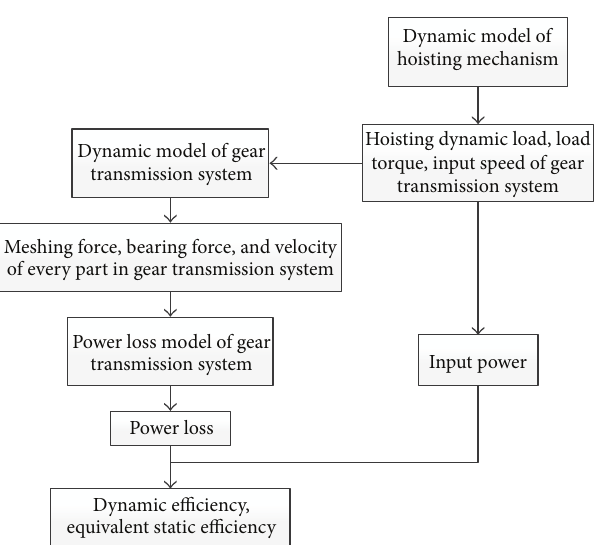
Figure 7: Numerical simulation flowchart.